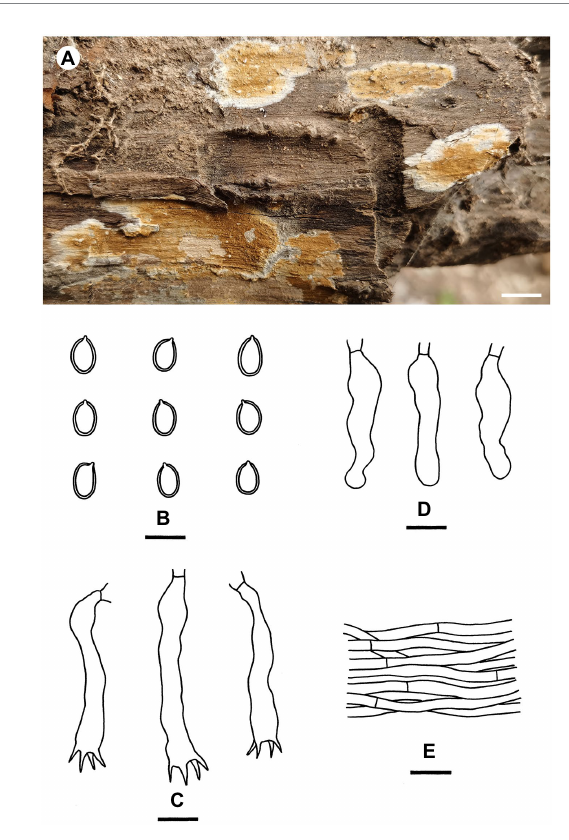
FIGURE 3 Coniophora beijingensis (from the holotype He 6635; scale bars: a = 1 cm; b–e = 10 μ m). (A) Basidiomes; (B) Basidiospores; (C) Basidia; (D) Basidioles; (E) Hyphae from subiculum.